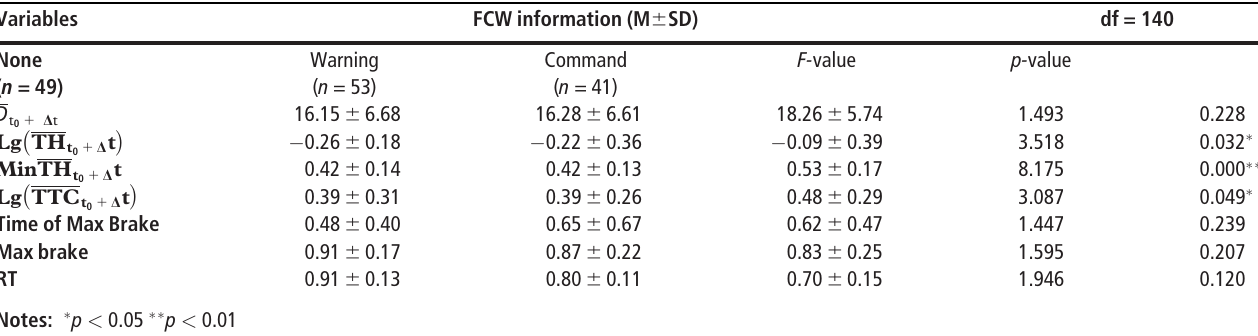
Table 4 ANOVA results in three FCW conditions Variables